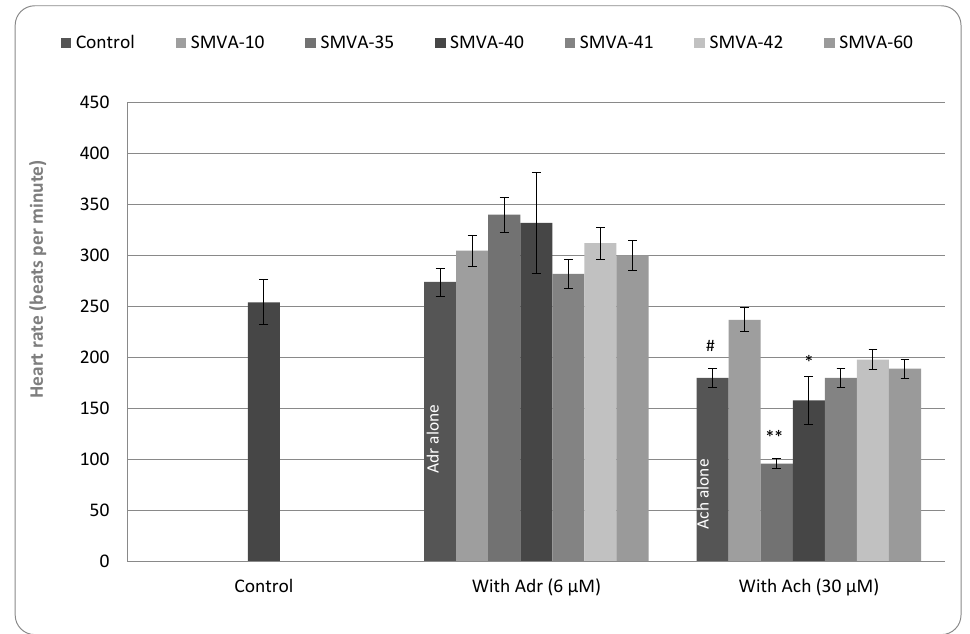
Figure 2. Effects of new synthetic derivatives of thiazole acetic acid on the heart rate (beats per minute) in isolated rat hearts in the presence of either Adr or Ach. Values are represented as mean ± SEM. Statistics: One-way ANOVA. # p < 0.05 compared with control and * p < 0.05, ** p < 0.001 compared with Ach.